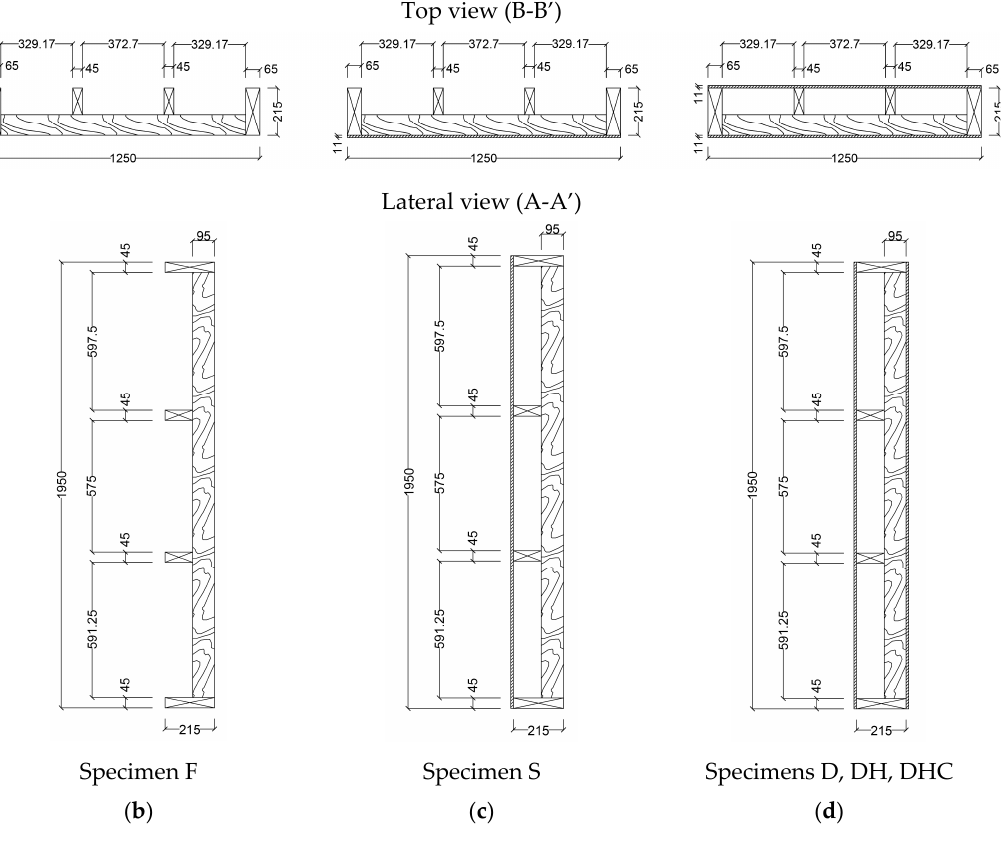
Figure 1. Details of the specimens tested (dimensions in mm).